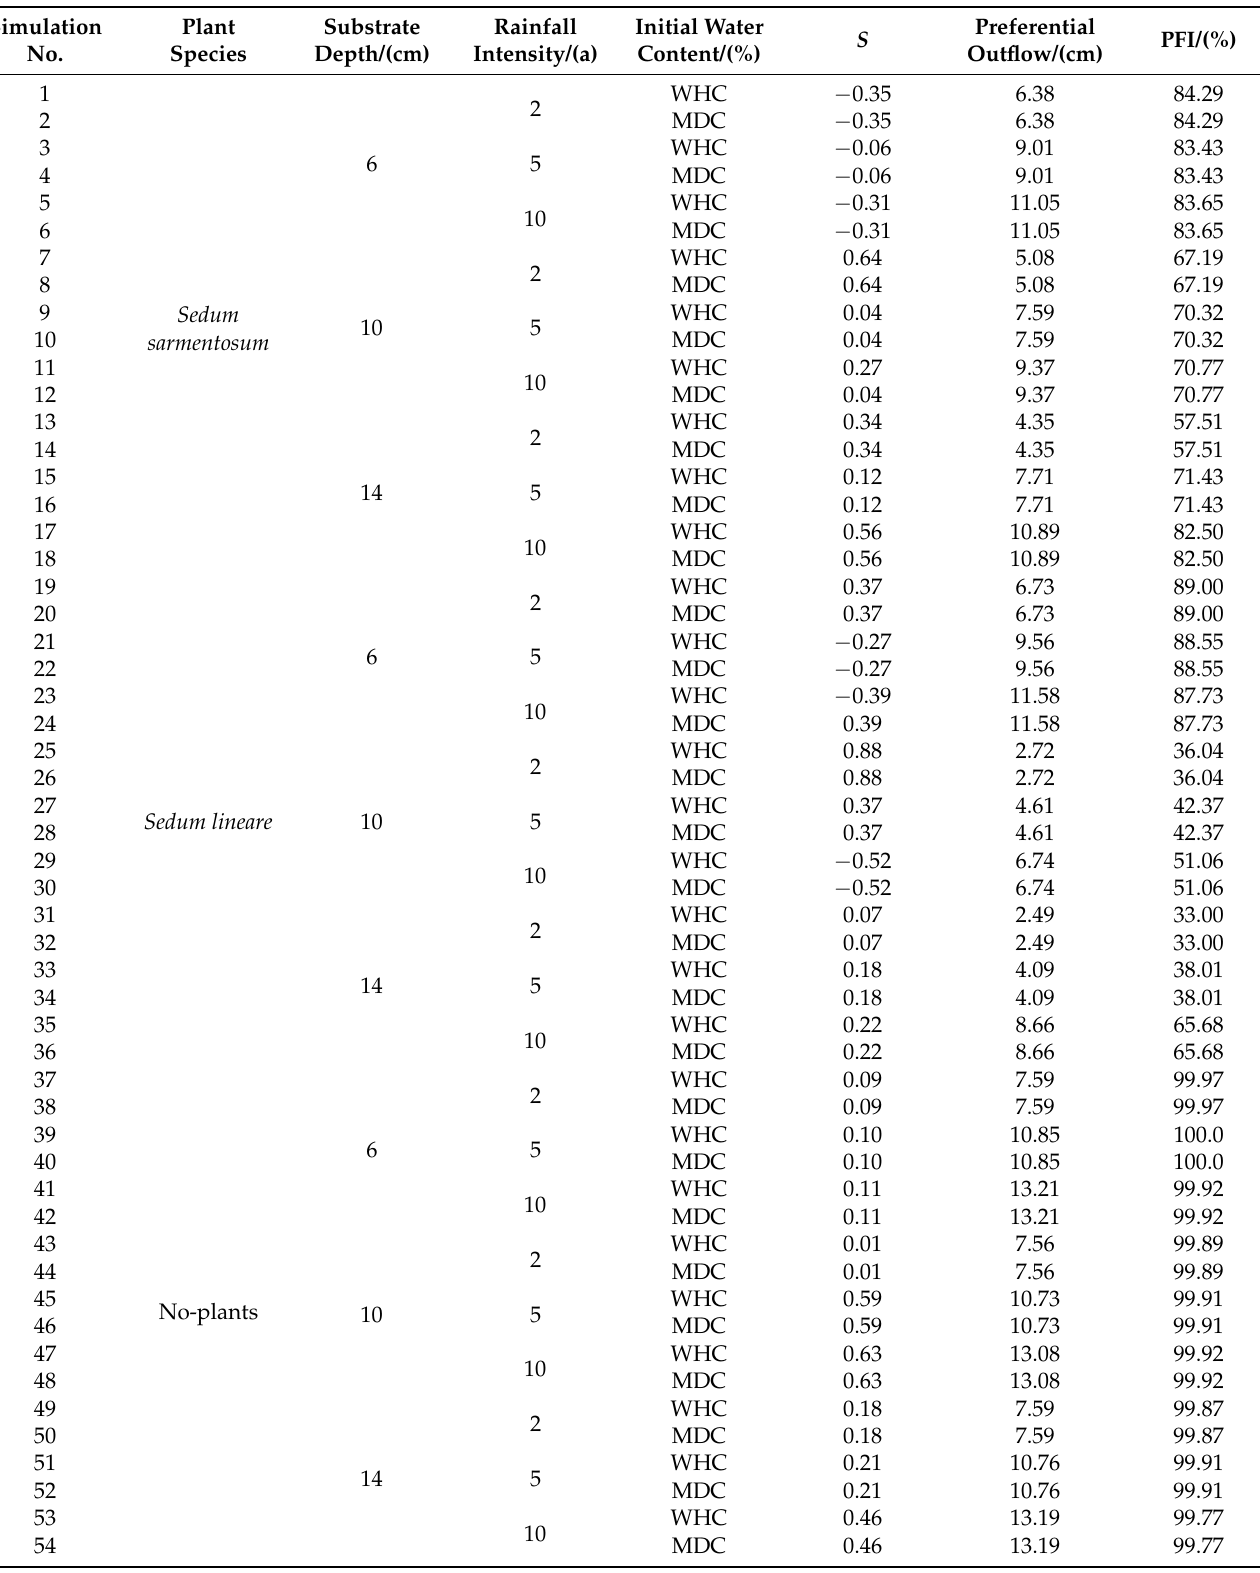
Table 6. Simulation results of PAS under different simulation